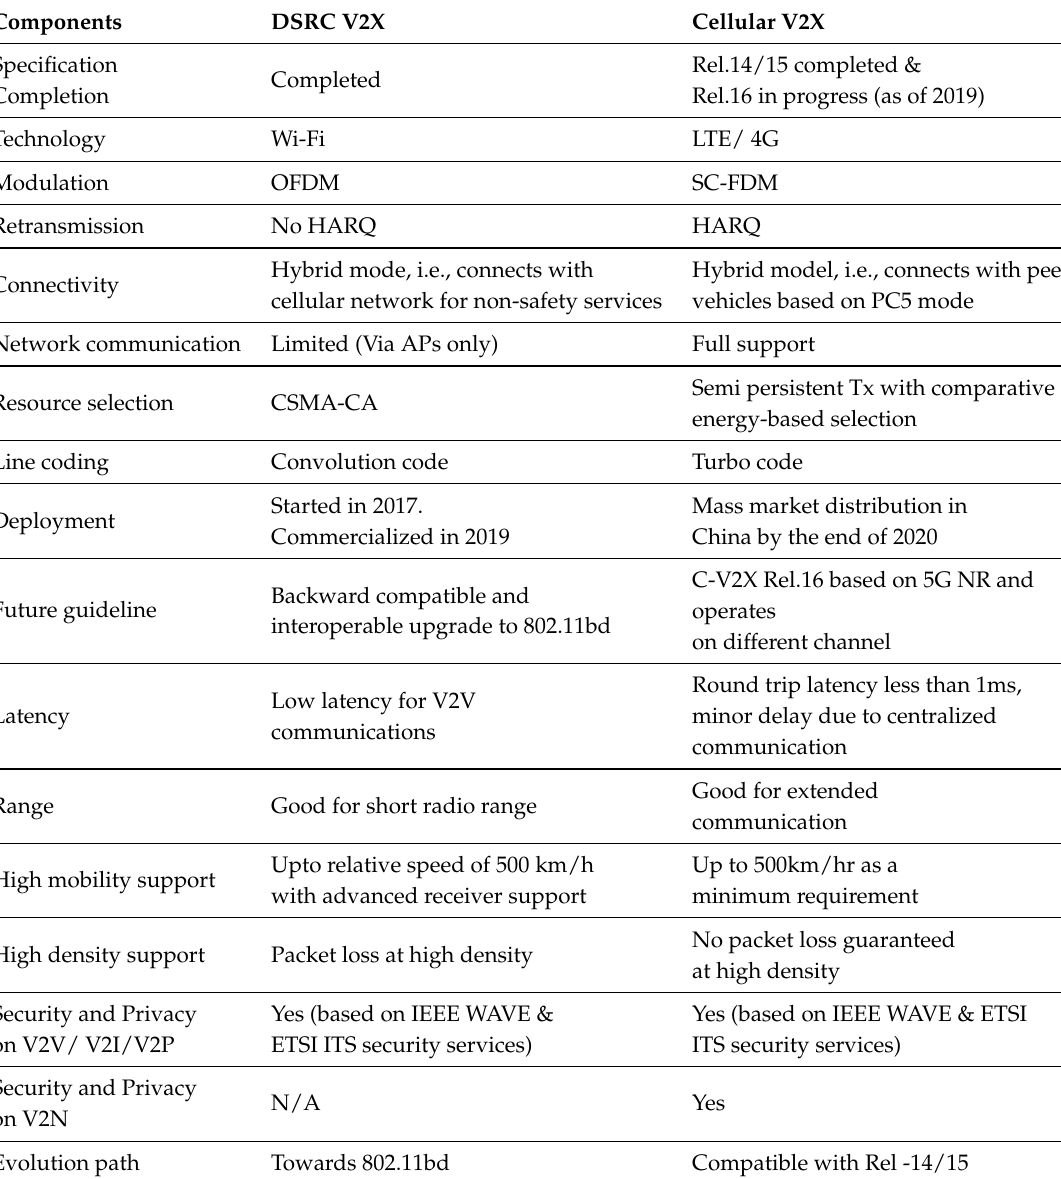
Table 1. Detailed Comparison of DSRC based and Cellular based V2X